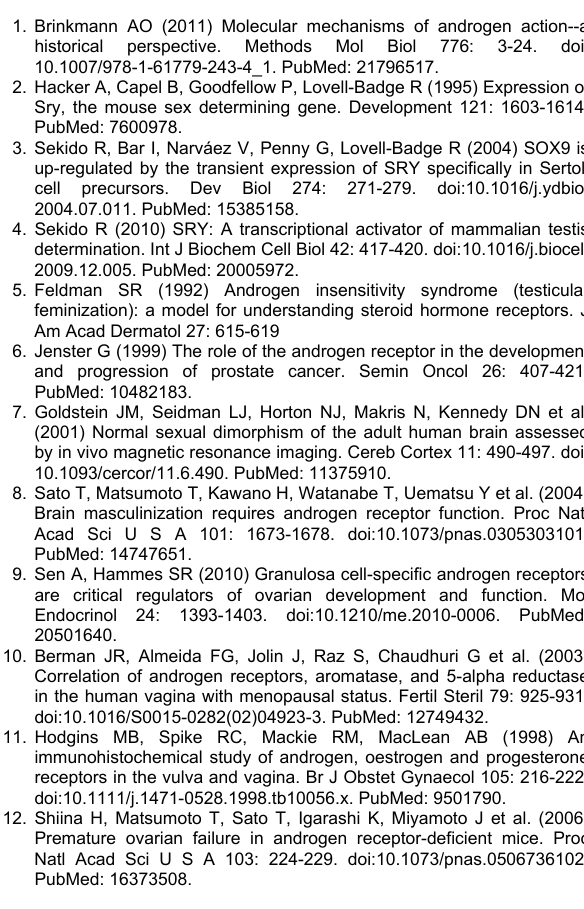
Methods S1. Further details are provided for Cell culture, Primary Cell Culture, Genomic DNA extraction and PCR,